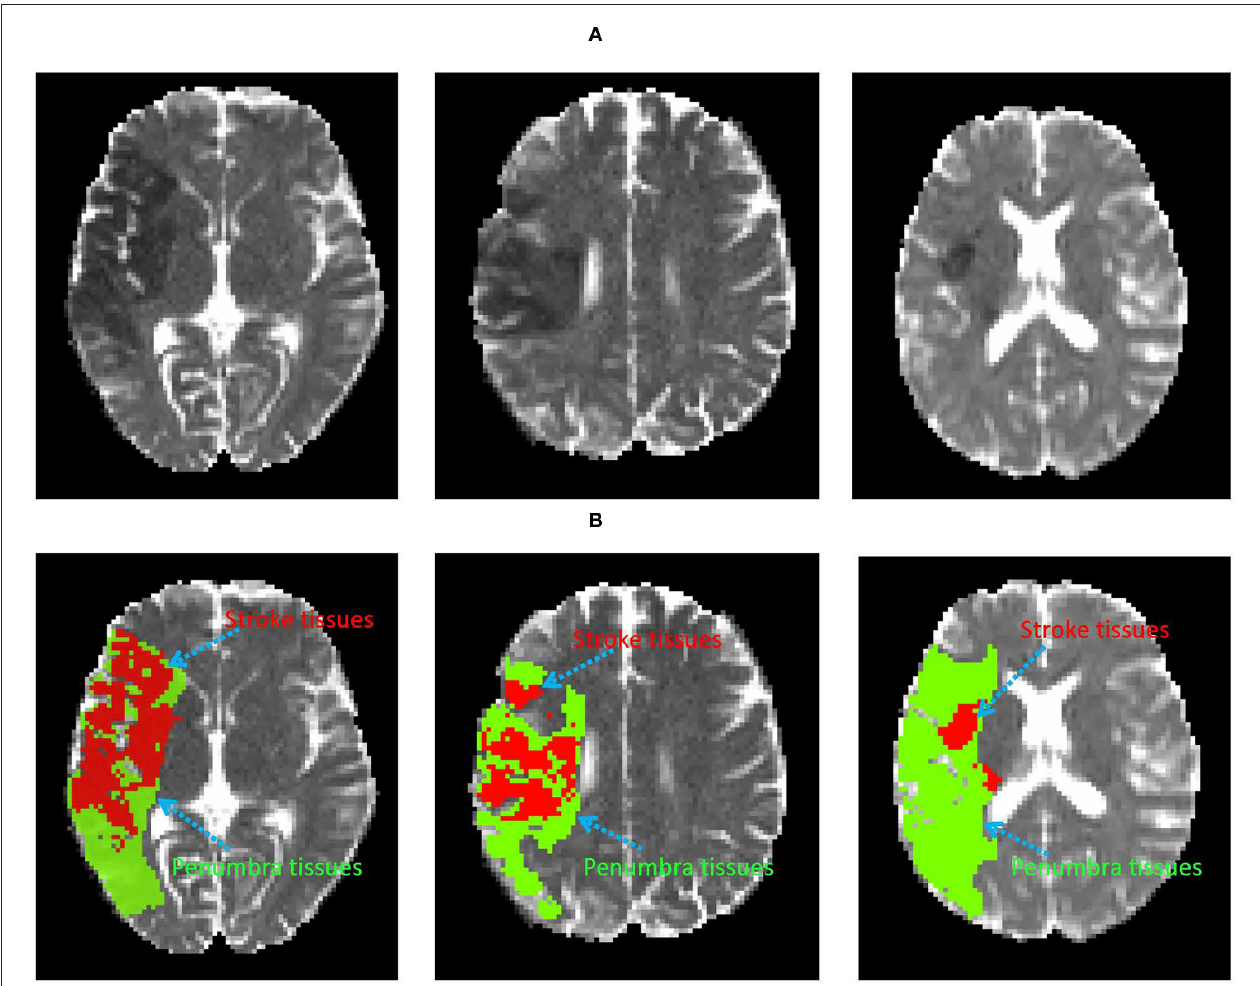
FIGURE 1 | Examples of the infarct core and penumbra tissues on DWI image (A) . The red and green area denote infarct core and penumbra tissues (B) ,